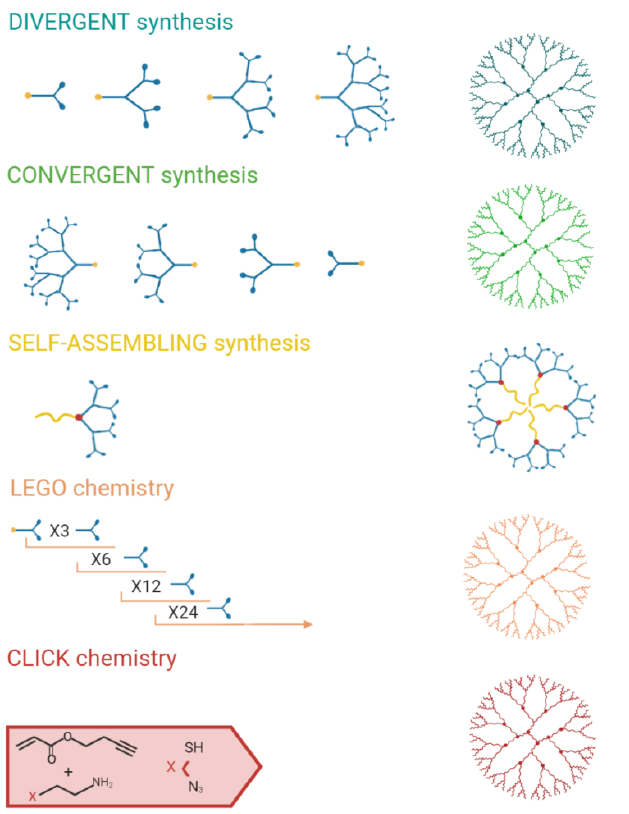
Figure 4. Synthetic strategies that can be exploited in dendrimer development. Created with Bio- Render.com.